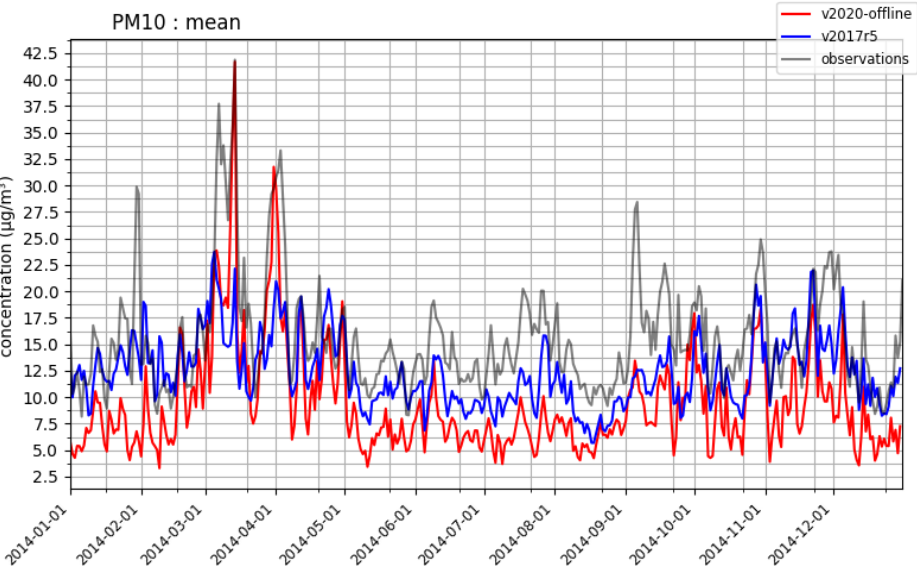
Figure 5. Time series of PM 10 daily mean surface concentrations measured with the EMEP network and modeled with CHIMERE v2017r5 and